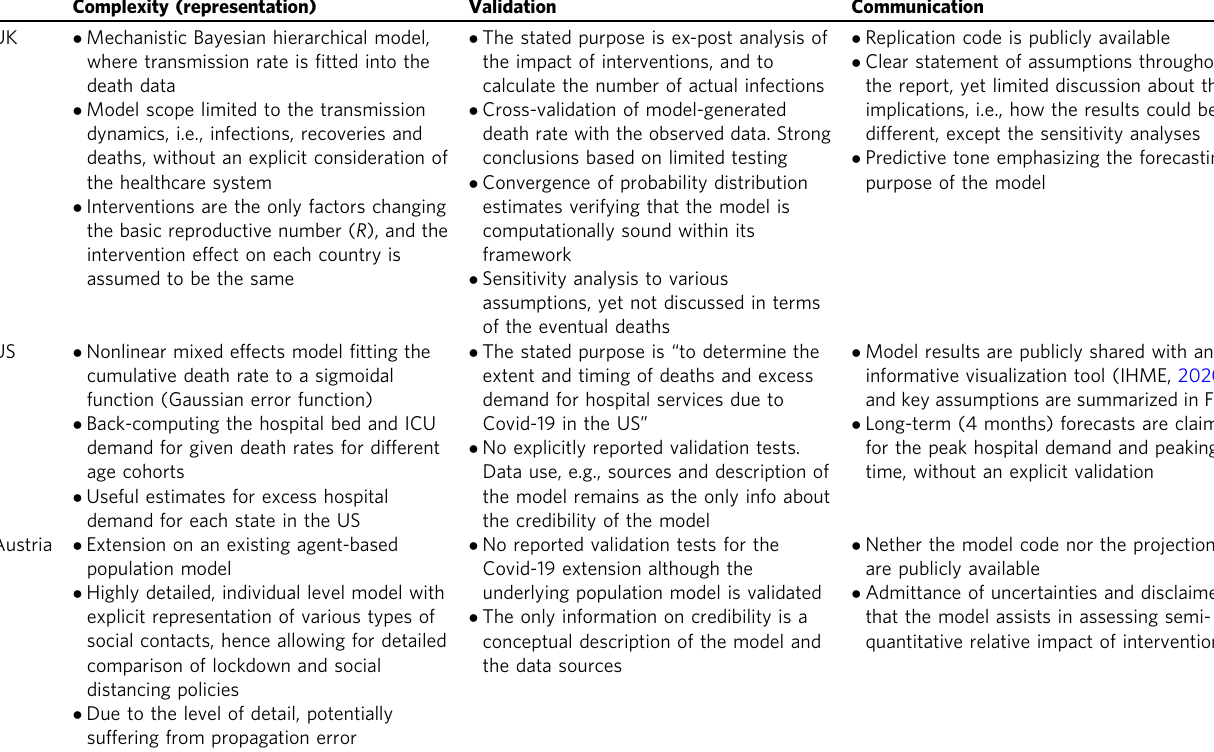
Table 1 Summary of the three Covid-19 models assisting public policy. Complexity (representation)